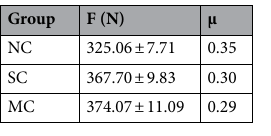
Table 2. Preload and friction